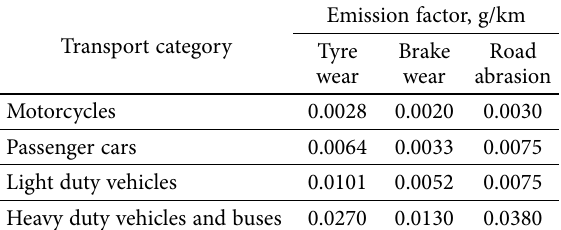
Table 2. PM 10 emission factors for tyre, brake wear and road abrasion